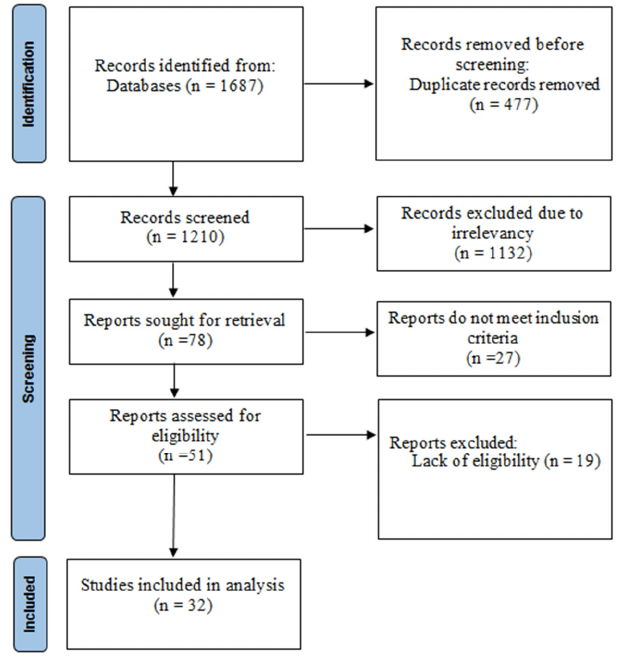
Figure 1. Flowchart of included studies.